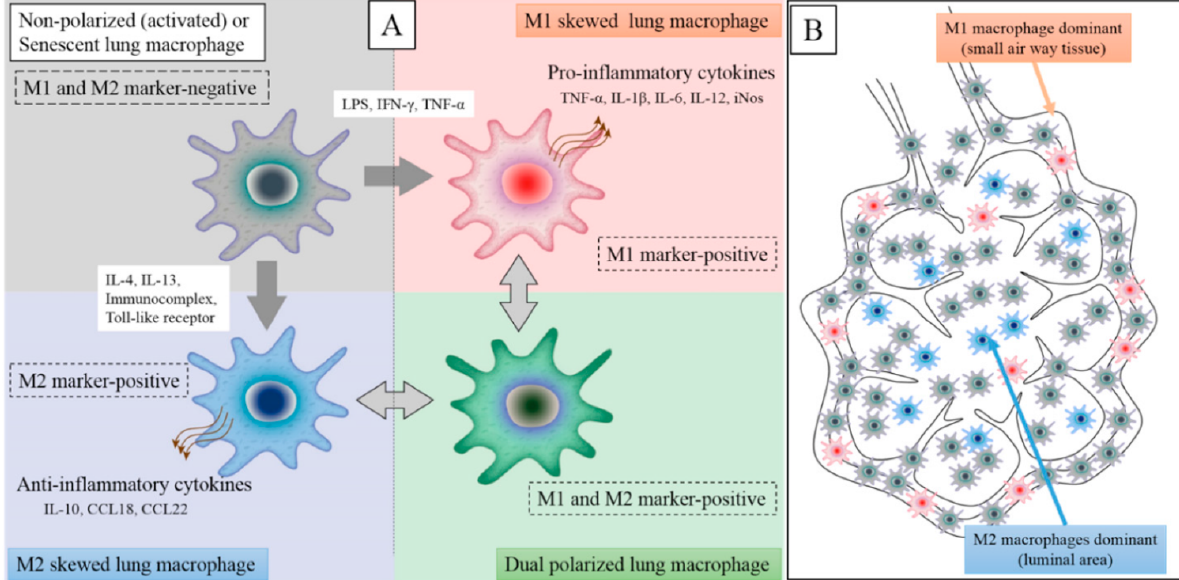
Figure 1. The M1 and M2 macrophage polarization states have distinct phenotypic properties. An inflammatory stimulus in the lungs, such as virus infection, lipopolysaccharide (LPS), dust particles, or IFN-γ, causes local macrophages to transition from M2 to M1 phenotype. Furthermore, circulating monocytes will be attracted into lung tissues and activated by the inflammatory stimulation, with M1 macrophages accounting for the majority of macrophages in the inflammatory zone (M1 dominant). Inducible nitric oxide synthase (iNOS), IL-6, IL-12, IL-1β, and TNF-α are inflammatory cytokines secreted by M1 macrophages. M2 macrophages release anti-inflammatory cytokines: C-C motif ligand 18 (CCL18), CCL22, and IL-10 Note. Adapted from “Lung macrophage phenotypes and functional responses: role in the pathogenesis of COPD,” by Yamasaki K, van Eeden SF. Int J Mol Sci. 2018;19:582 (https://doi.org/10.3390/ijms19020582). CC